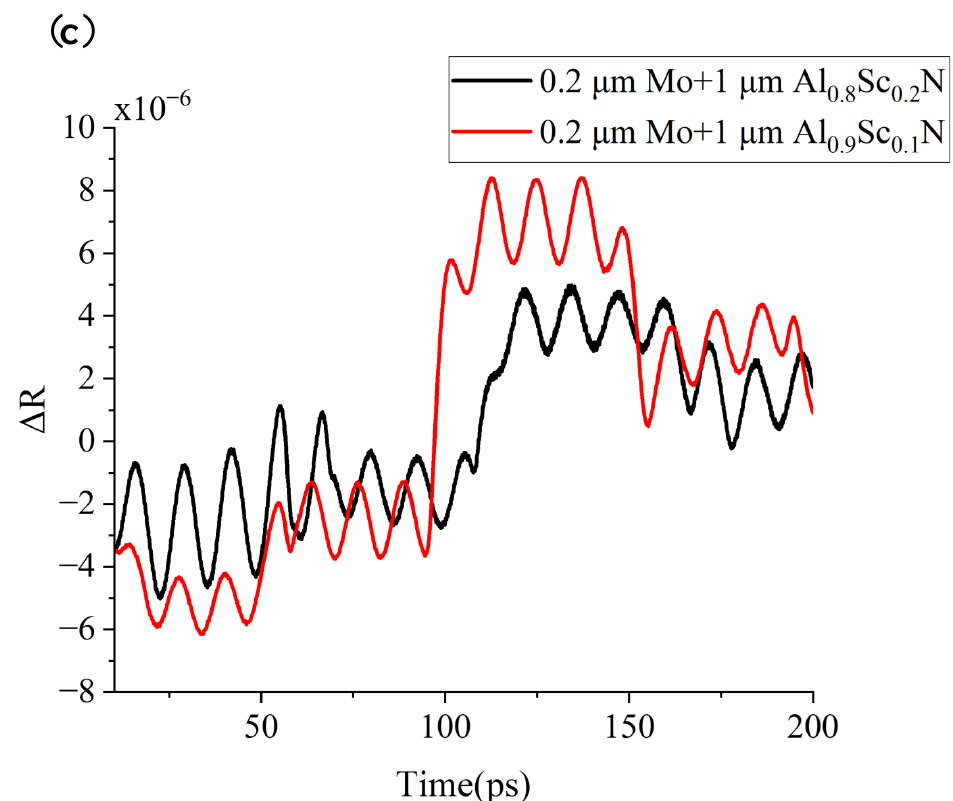
Figure 5. ( a ) Waveform diagram and SEM picture of sample E at (0,0) point. After picosecond ultrasound testing, the sample E is Mo-plated in order to reduce the influence of electron charging during SEM measurement. ( b )Waveform diagram and SEM picture of sample G at (0,0) point. ( c ) Comparison of the waveforms of sample E and sample F at the (90,0) point.